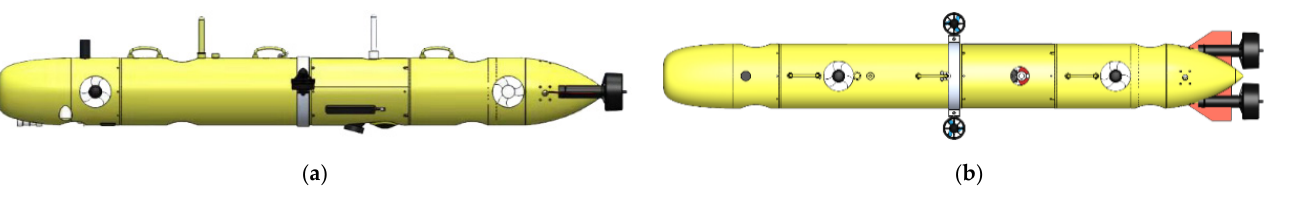
Figure 10. ( a ) The propulsion system of the S-AUV in the side view, ( b ) The propulsion system of the S-AUV in the vertical view.